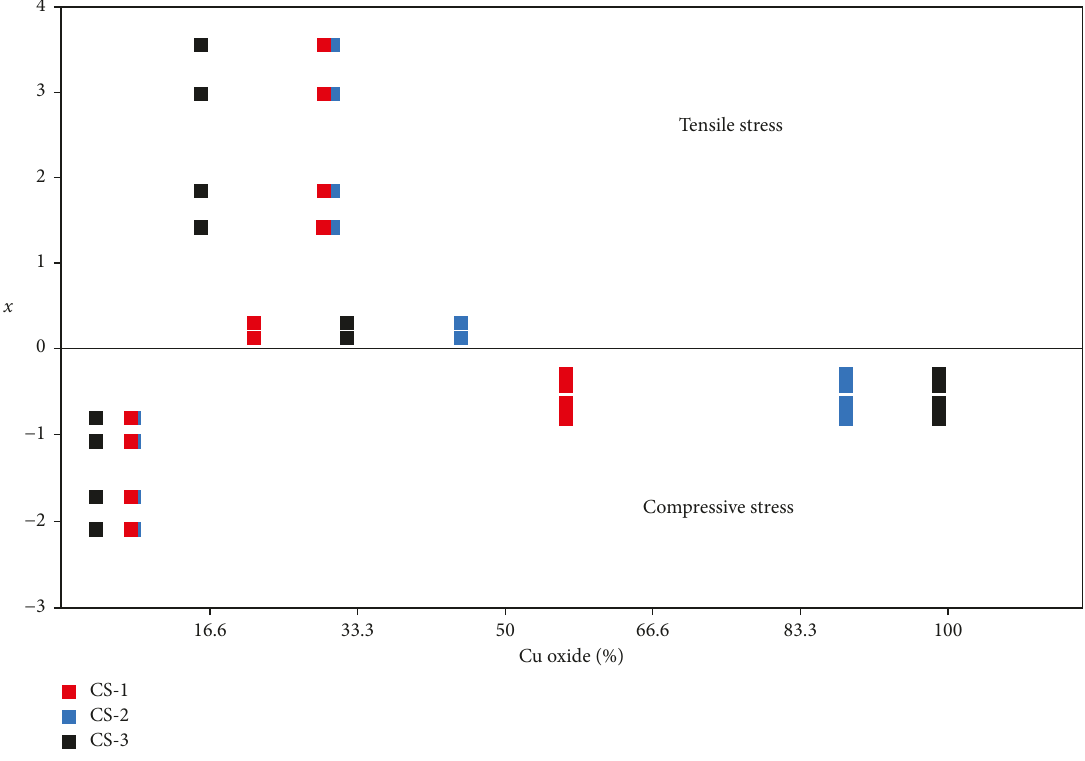
Figure 5: Correlation profile for different Cu oxide